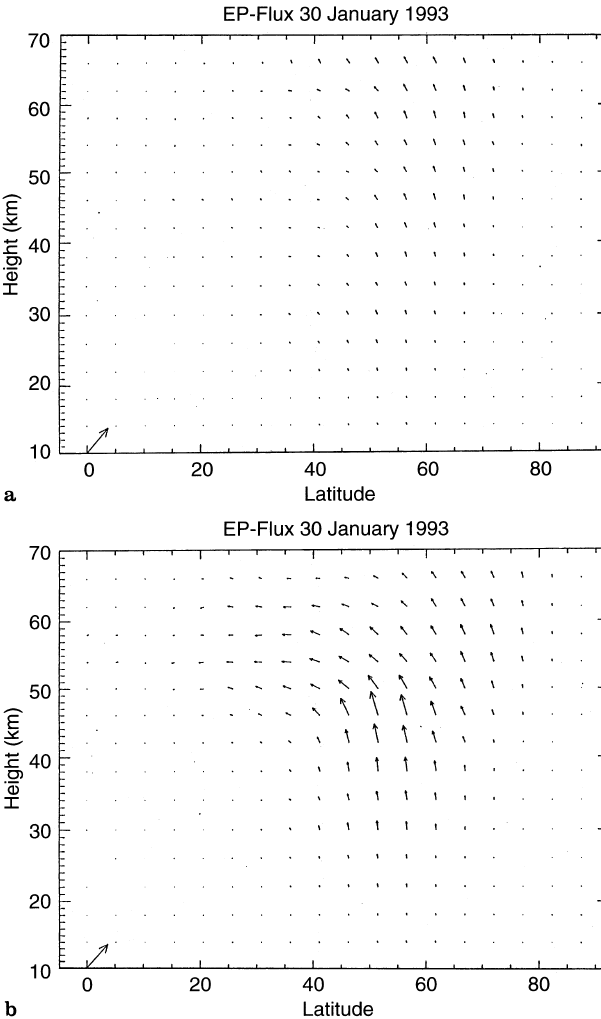
Fig. 8a,b. Northern Hemisphere normalised Eliassen-Palm fluxes scaled by 1/ (cid:113) for a solar minimum and b solar maximum